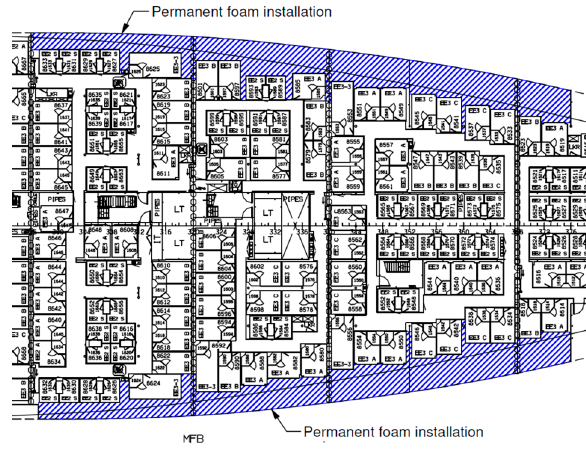
Figure 14. Permanent filling of void spaces in the wing compartments of a cruise ship.